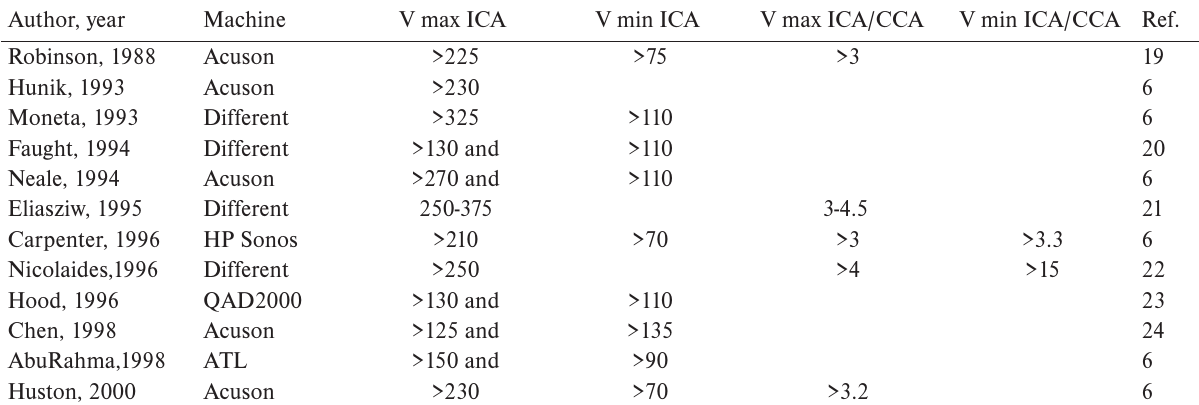
Table 3. Published Duplex velocity criteria for grading of 70% internal carotid artery stenosis.